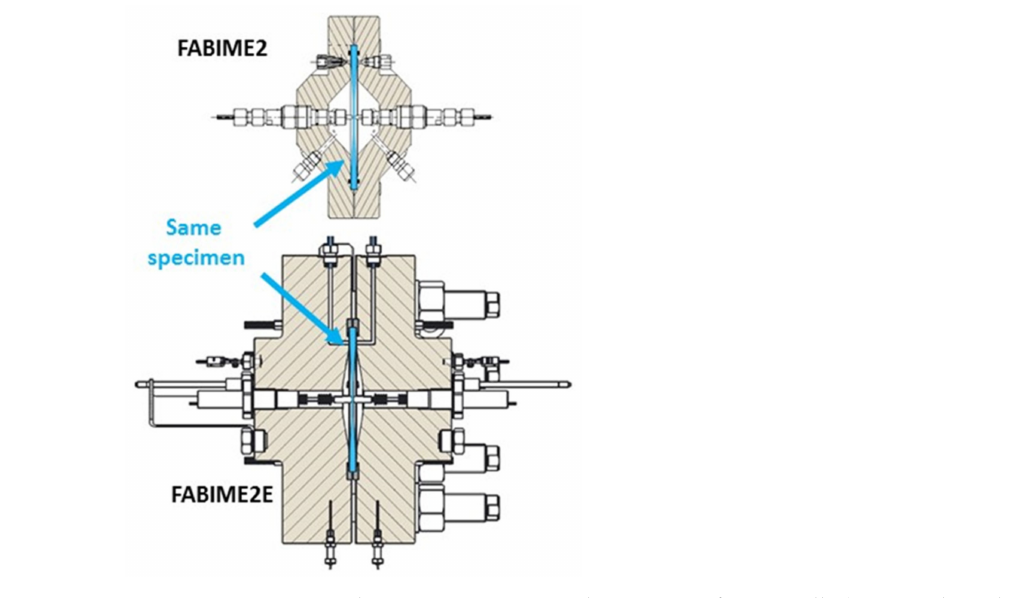
Figure 6. Comparison between FABIME2 and FABIME2e fatigue cells (same scale and specimen geometry, ∅ = 170